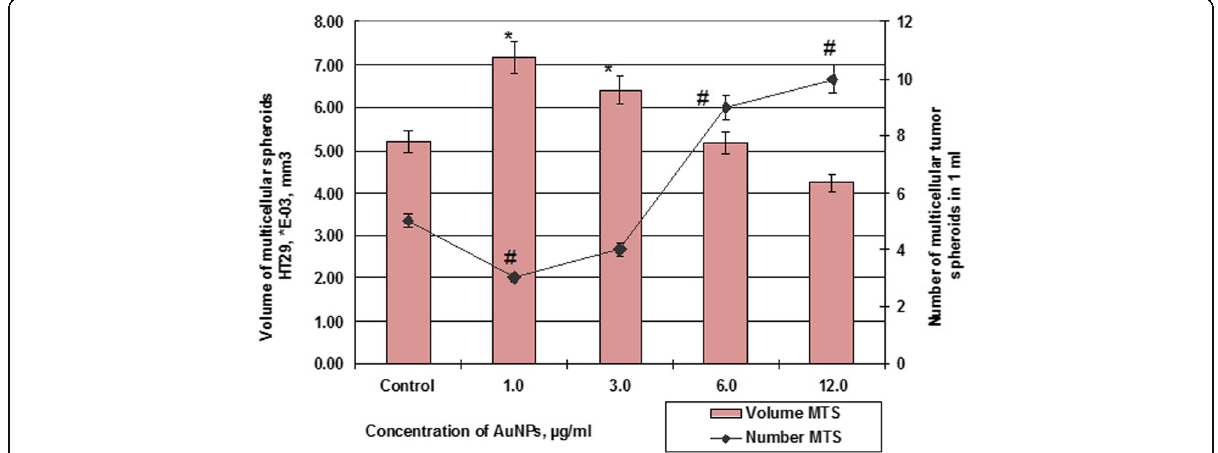
Fig. 7 Number and volume of MS cells HT29 after incubation with AuNPs. # p ≤ 0.01 (for number MSs); ** p ≤ 0.01 (for volume of